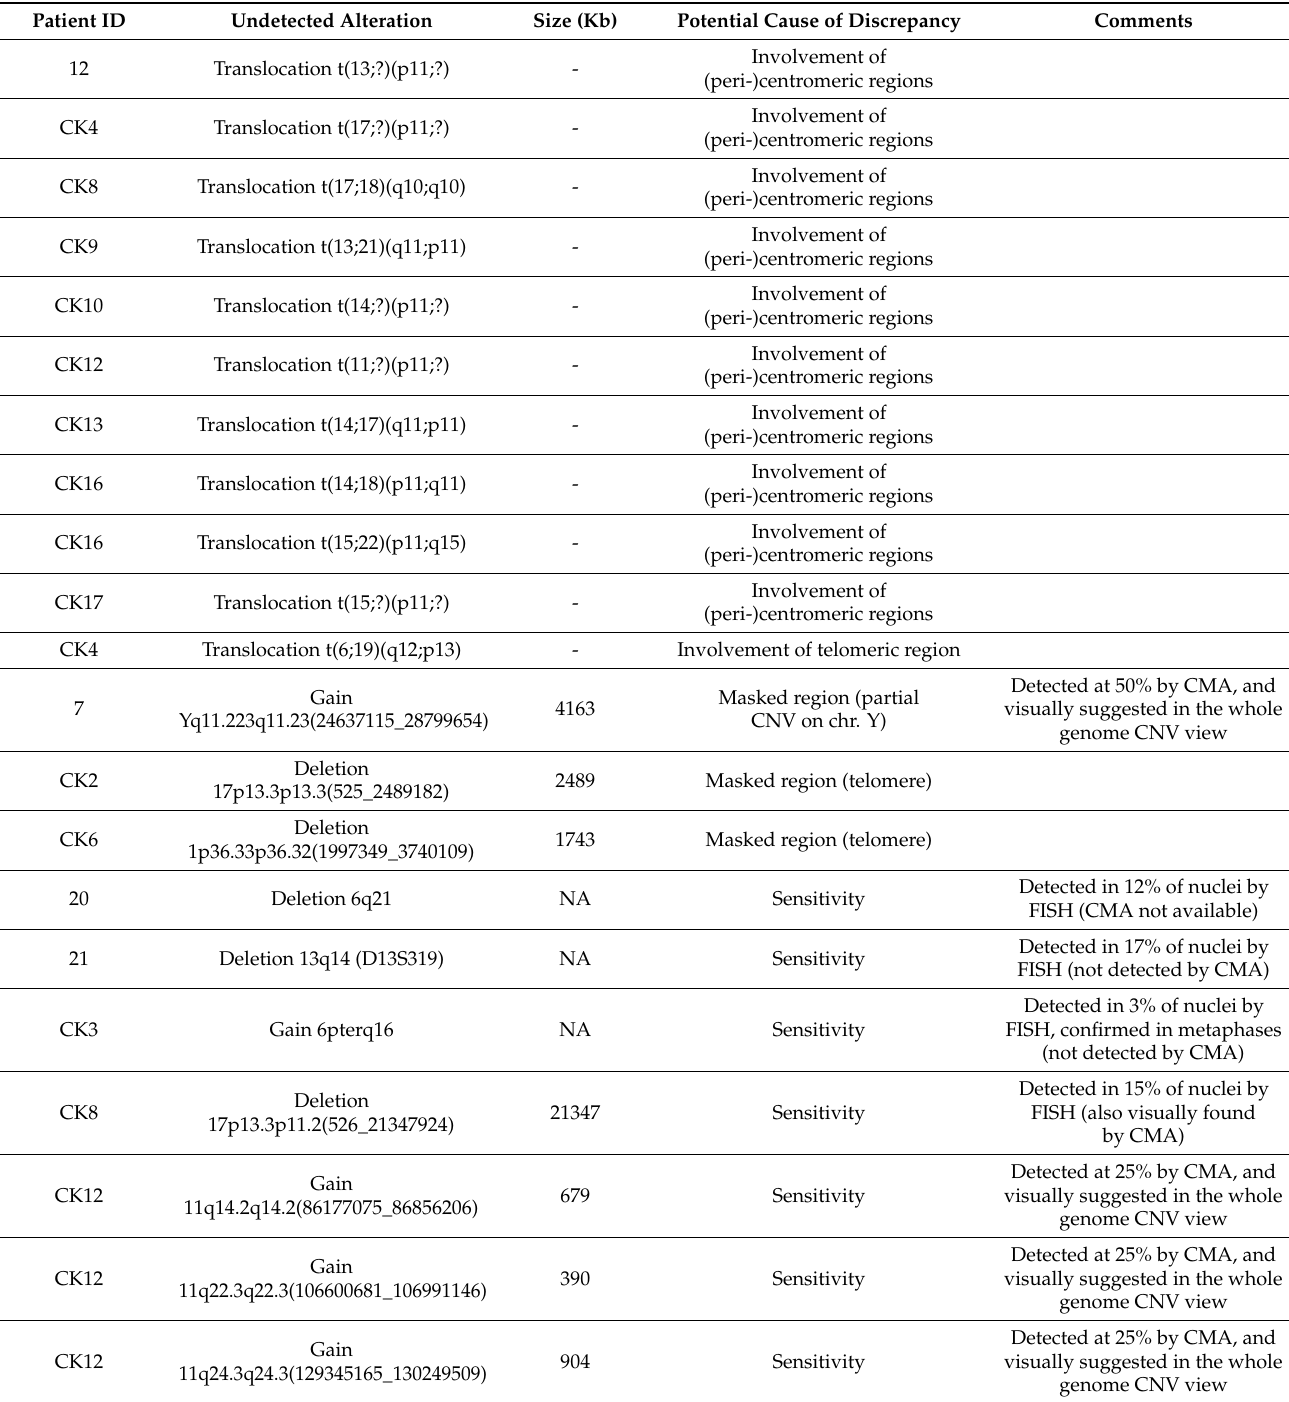
Table 2. Known abnormalities not detected by OGM and their potential cause of